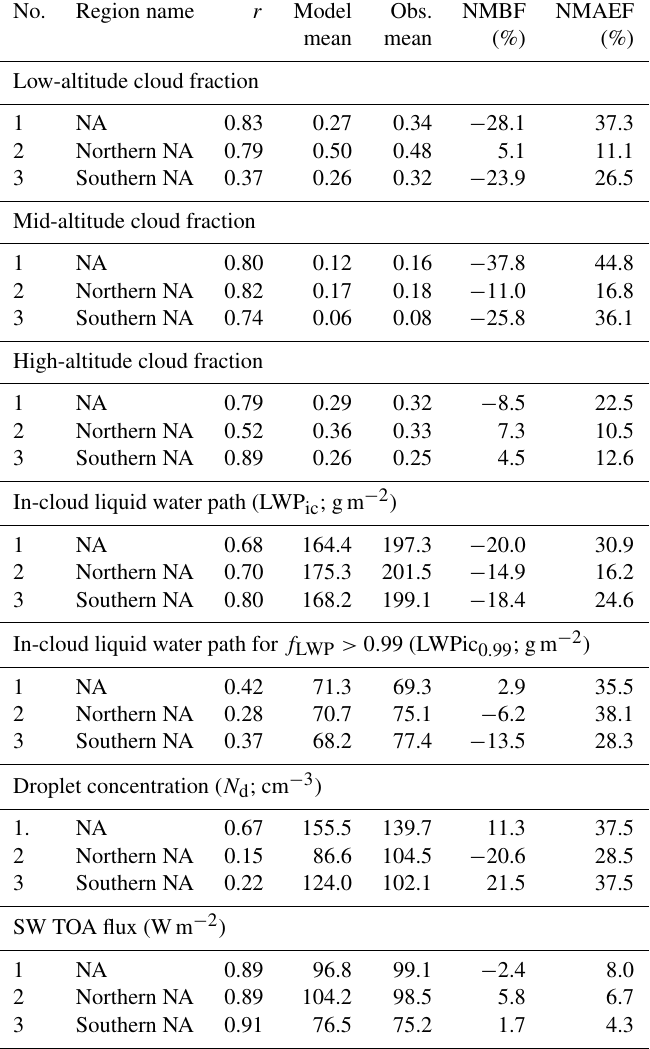
Table 2. Model evaluation statistics for the various subregions using time-averaged data. The normalized mean bias factor (NMBF) and the normalized mean absolute (NMAEF) error factor statistics are used following Gustafson and Yu (2012); see Appendix B for definitions. r is the spatial correlation coefficient between the model and observed time averages. All values are area weighted to account for the variation in area of the model grid